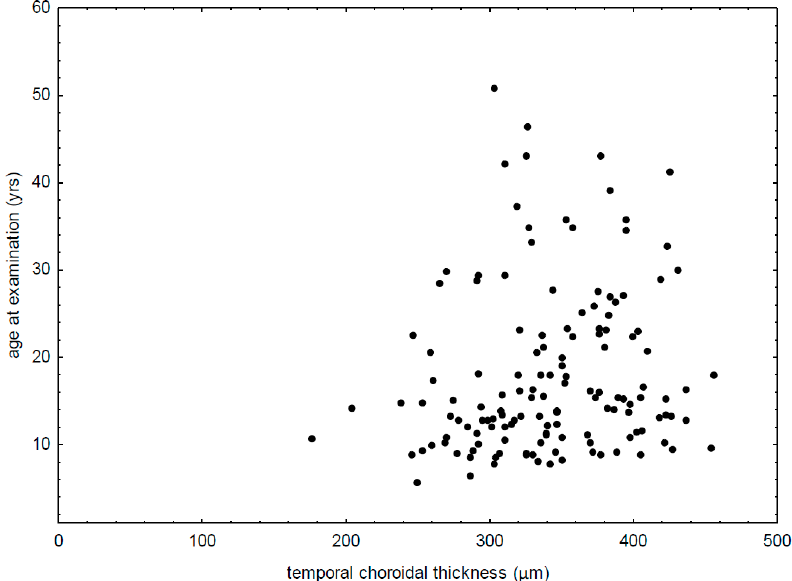
Figure 3. Correlation between temporal choroidal thickness and age at examination in patients with type 1 diabetes (R = 0.21, p =